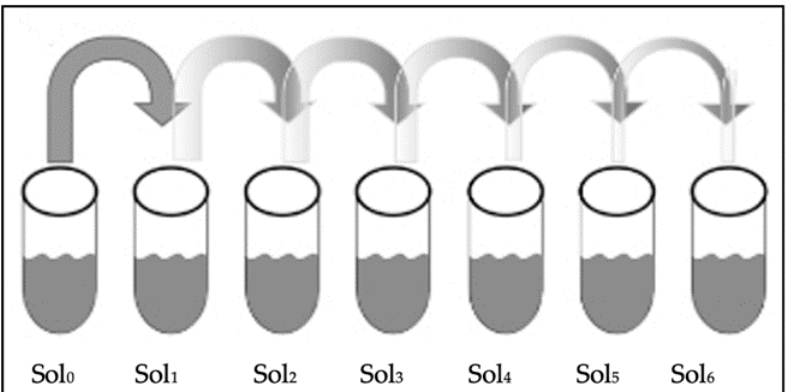
Figure 1. Serial dilution stock of bacteria (Sol 0 ) up to the sixth dilution (Sol 6 ).